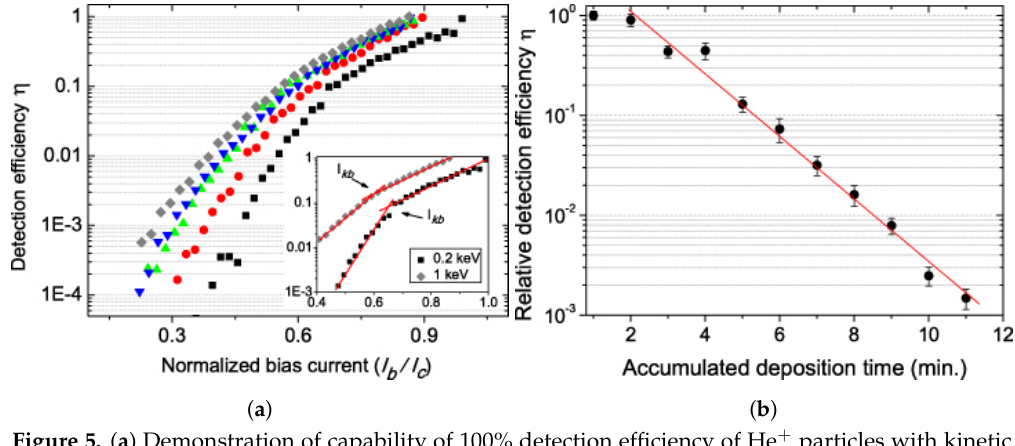
Figure 5. ( a ) Demonstration of capability of 100% detection efficiency of He + particles with kinetic energies of 200 eV (square), 400 eV (circle), 600 eV (up-triangle), 800 eV (down-triangle) and 1000 eV (diamond). The points I kb corresponds to bias current value where the primary cause for hot-spot expansion changes from fluctuation-based into current-crowding regime. ( b ) Relative detection efficiency as a function of accumulated deposition time of neutral He atoms. Figures reproduced from Sclafani, et al., Nanotechnology 23 , 065501 (2012)